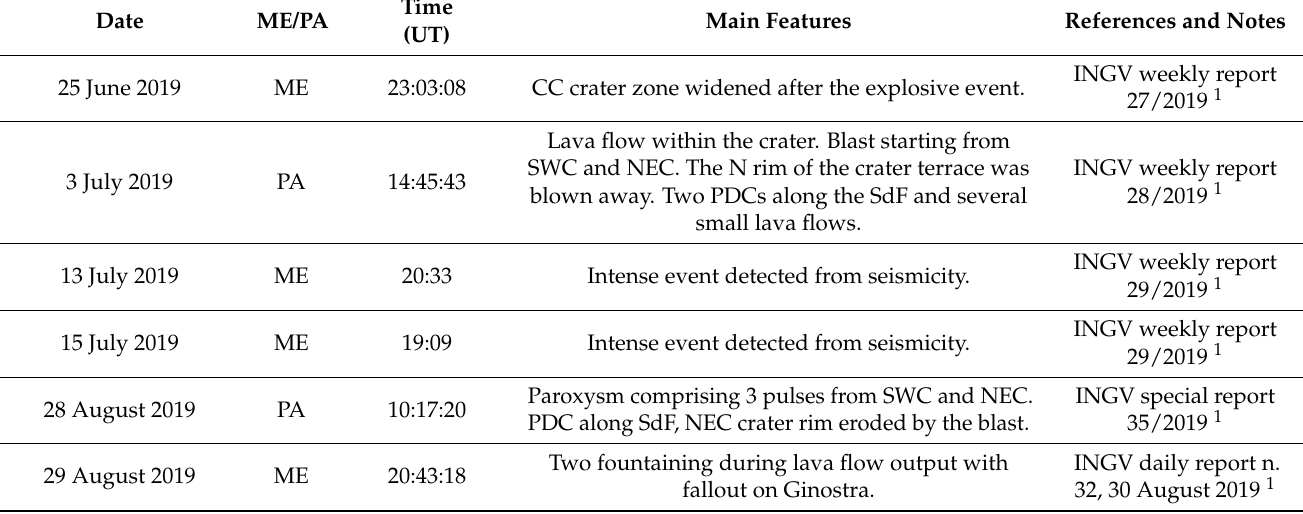
Table 3. List of major explosions (ME) and paroxysms (PA) at Stromboli since 25 June 2019 and updated to 6 Dec 2020. The date, time and features of the events are from the INGV weekly reports on the monitoring activity. NEC = NE crater zone; CC = central crater zone; SWC = SW crater